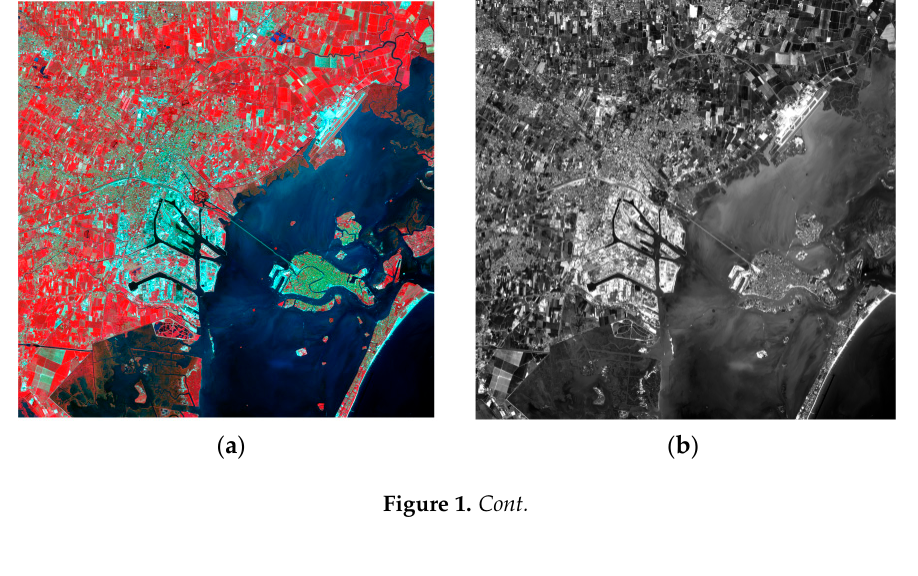
Figure 1. Cont. Figure 1.